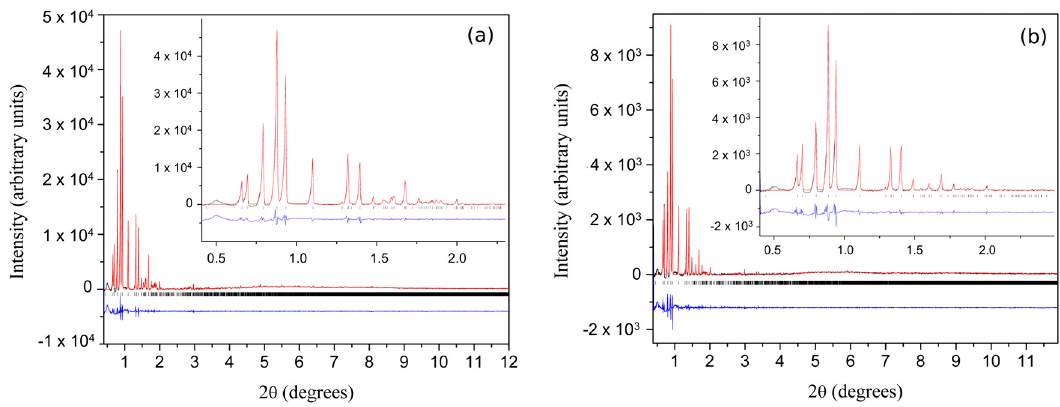
Figure 6. Pawley fit of synchrotron data (European Synchrotron Radiation Facility (ESRF), λ = 1.299825 (16) Å, room temperature (RT)) obtained from Human Insulin (HI) samples belonging to the P 2 1( α ) phase, crystallized in the presence of ( a ) phenol, at pH 5.70, or ( b ) resorcinol, at pH 5.29. The black, red and lower blue lines represent the experimental data, the calculated pattern and the difference between them, respectively, while black vertical bars correspond to Bragg reflections compatible with P 2 1 space group (Reproduction of Figure 6 from reference [29]. Reproduced with permission of the International Union of Crystallography).